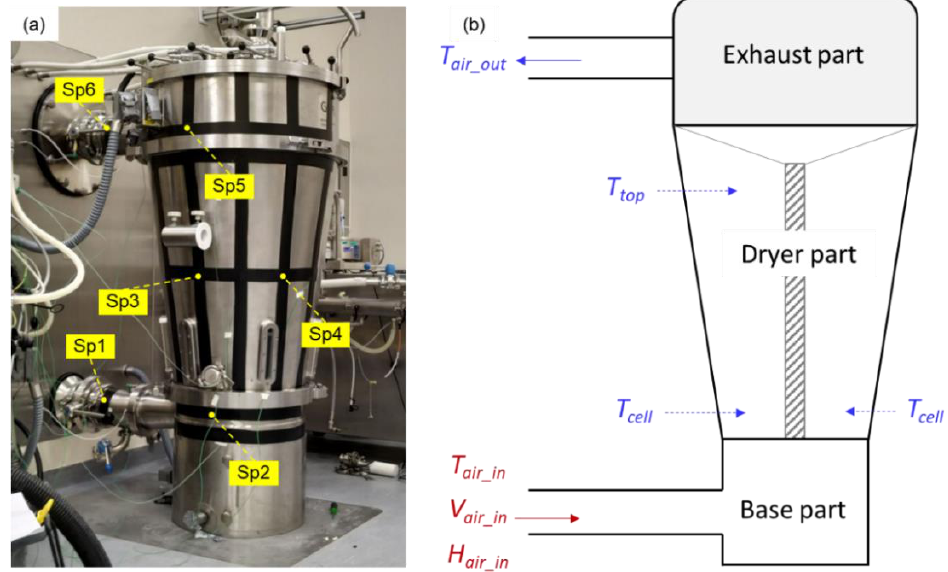
Figure 2. ( a ) Seg-FBD with black tapes on surface for FLIR measurement, and ( b ) schematic diagram of the Seg-FBD and temperature measurement positions inside the Seg-FBD.